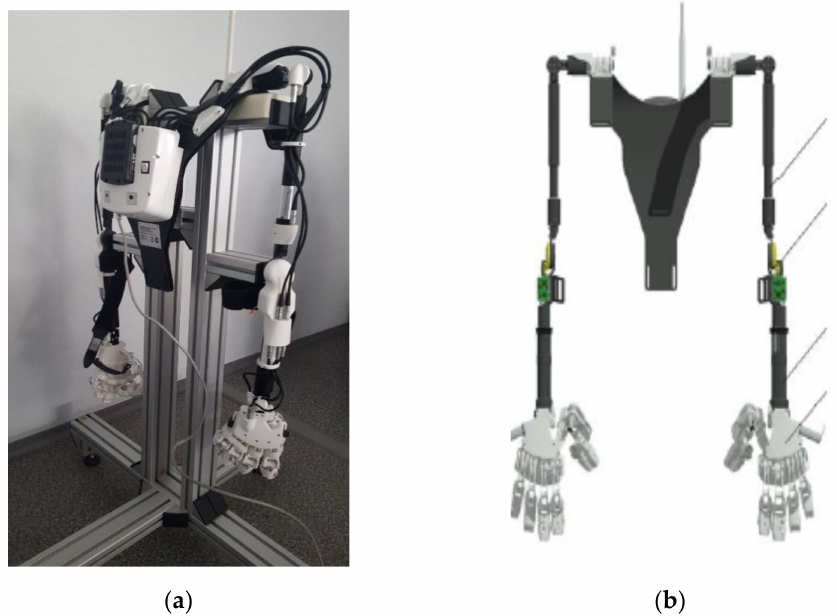
Figure 3. Copy-type master devices. ( a ) for the robot SAR-401; ( b ) for underwater robot “Ichthyandr”.